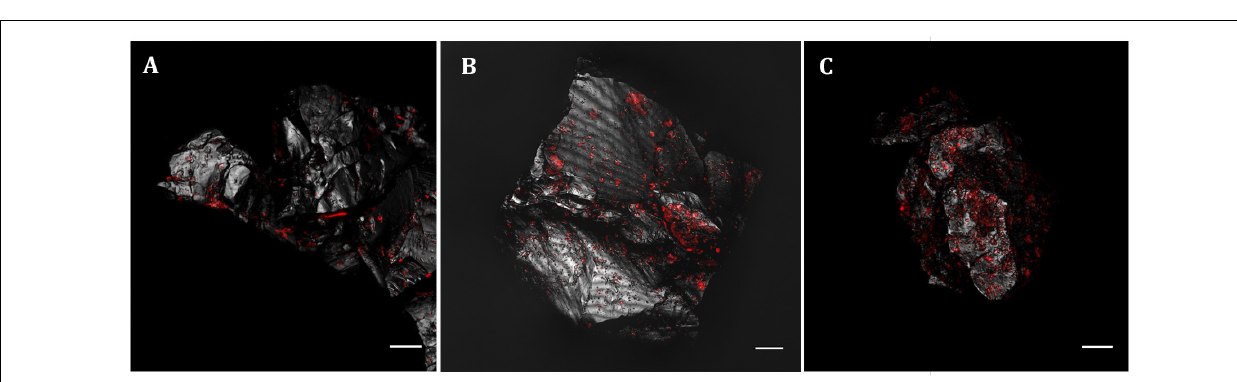
FIGURE 2 | Acidovorax genus members detected by CARD-FISH in IPB subsurface rock samples at –139.4 m (A) , –206.6 m (B) and –284 m (C) . In red, CARD-FISH signal. In gray, reflection. Scale bars, 10 µ m.